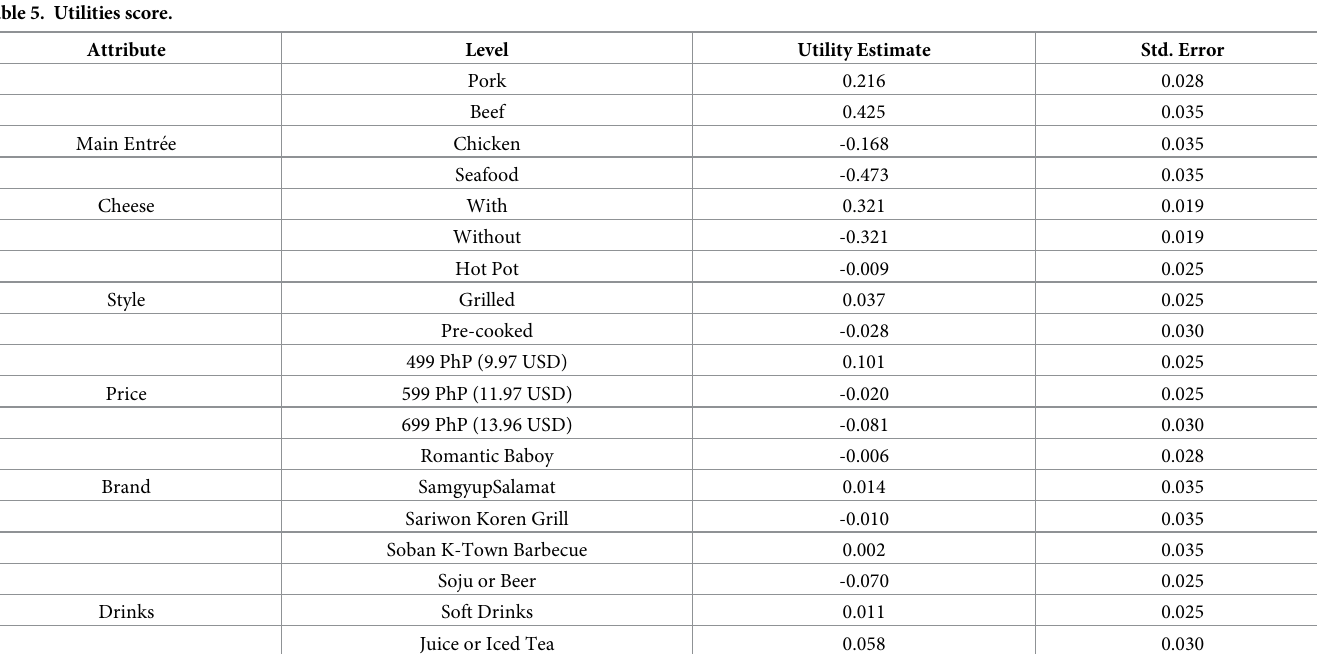
Table 5. Utilities score.